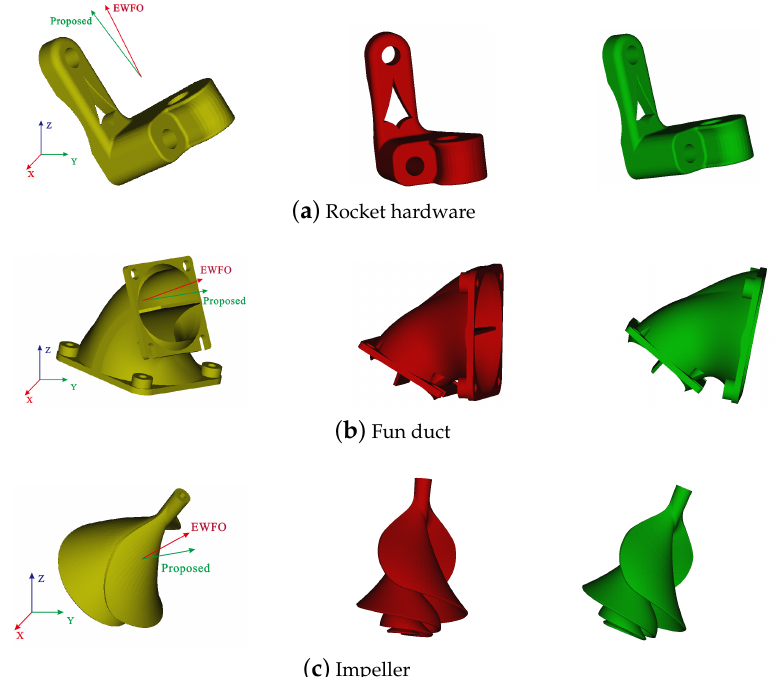
Figure 11. Comparison of the proposed algorithm and the EWO method.